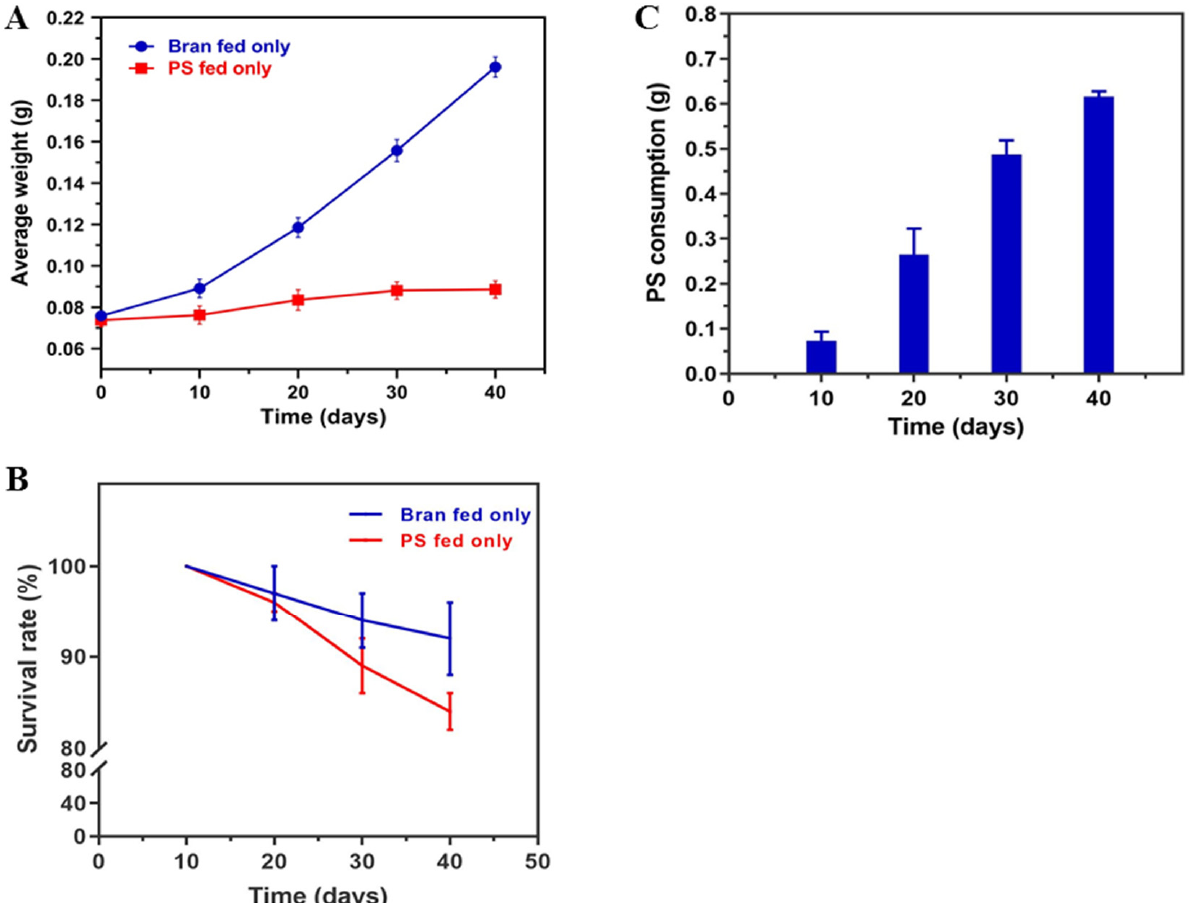
Figure 1. Vital signs of T. molitor larvae and degradation rate of PS. ( A ). The blue and red curves represent the average weight of the control group (wheat bran group) and the PS group (PS foam only), respectively. ( B ). Survival rates of T. molitor fed PS only compared with that fed bran. ( C ). The blue bar chart represents the cumulative consumption of PS by mealworms (measured every 10 days). The results are presented as mean ± standard error of mean (SEM) (fifty larvae as a group, n = 3) .